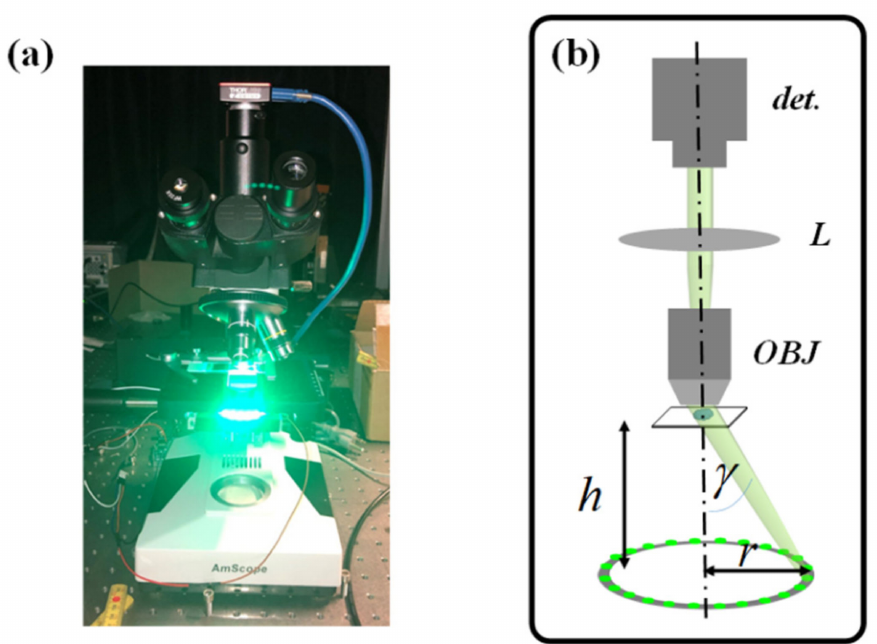
Figure 3. Experimental setup. ( a ) bright-field microscope equipped with an LED ring. ( b ) Schematic of the system with its different parts. (OBJ: objective lens, L: lens, det.: detector). The LED ring is perfectly aligned with the optical axis for better quality of the reconstruction. The distance ( h ) is controlled to ensure a perfect match between the illumination and imaging NA .